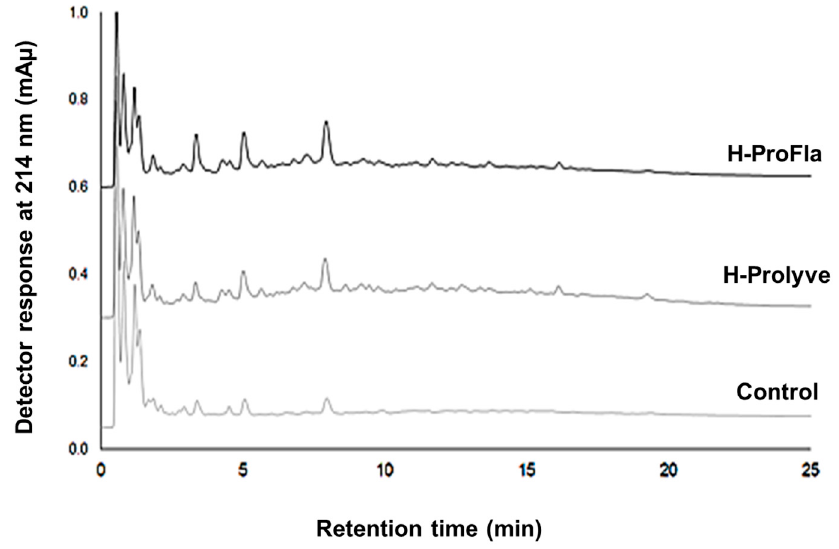
Figure 3. Reversed-phase ultra-performance liquid chromatography profiles of P. dioica conchocelis following 2 h hydrolysis at 50 ◦ C with Prolyve (H-Prolyve) and a total of 4 h hydrolysis with Prolyve plus Flavourzyme